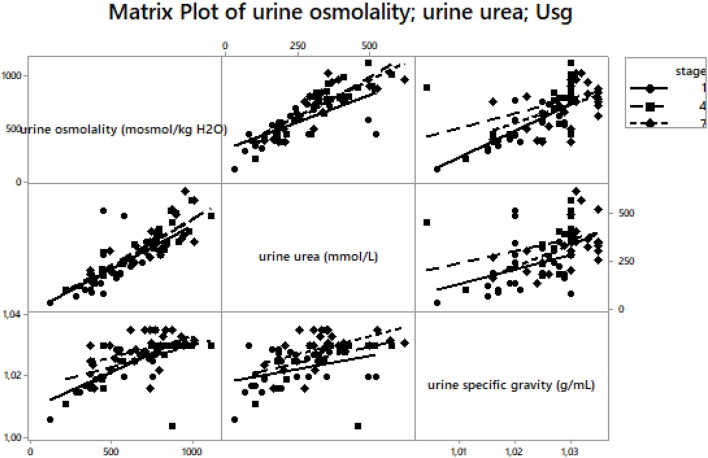
A matrix plot of urine osmolality, urine urea and urine specific gravity at A1, A4 and A7. Usg – urine specific gravity. Urine osmolality was significantly associated with urine specific gravity (r = 0.71, p < 0.001) at A1, (r = 0.52, p = 0.006) at A4 and (r = 0.46, p = 0.02) at A7. Urine osmolality was significantly associated with urine urea at A1 (r = 0.80, p < 0.001), at A4 (r = 0.81, p < 0.001) and at A7 (r = 0.86, p < 0.001). Urine specific gravity was associated with urine urea (r = 0.39, p = 0.05) at A1. Other correlations were not significant (p > 0.05).